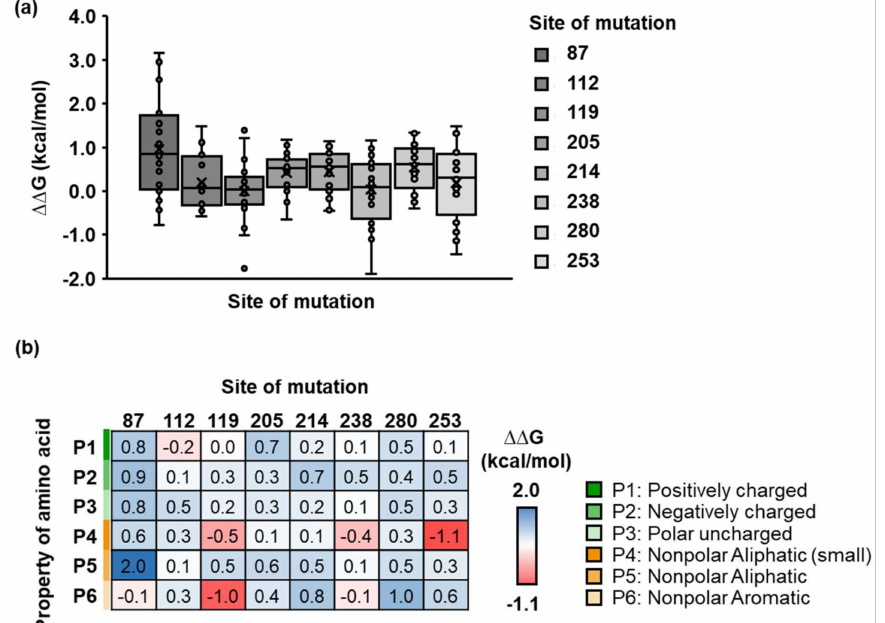
Figure 3. Single site-saturation mutagenesis of PETase on a selected mutation site. ( a ) The boxplot showed the ∆∆ G distribution of the PETase variant and PET substrate complex with respect to the WT PETase. The dots showed the ∆∆ G of an individual PETase variant of each mutation site. ( b ) The color map illustrated the ∆∆ G distribution as a function of the mutation sites and the physicochemical properties of side chains (P1–P6 described in the